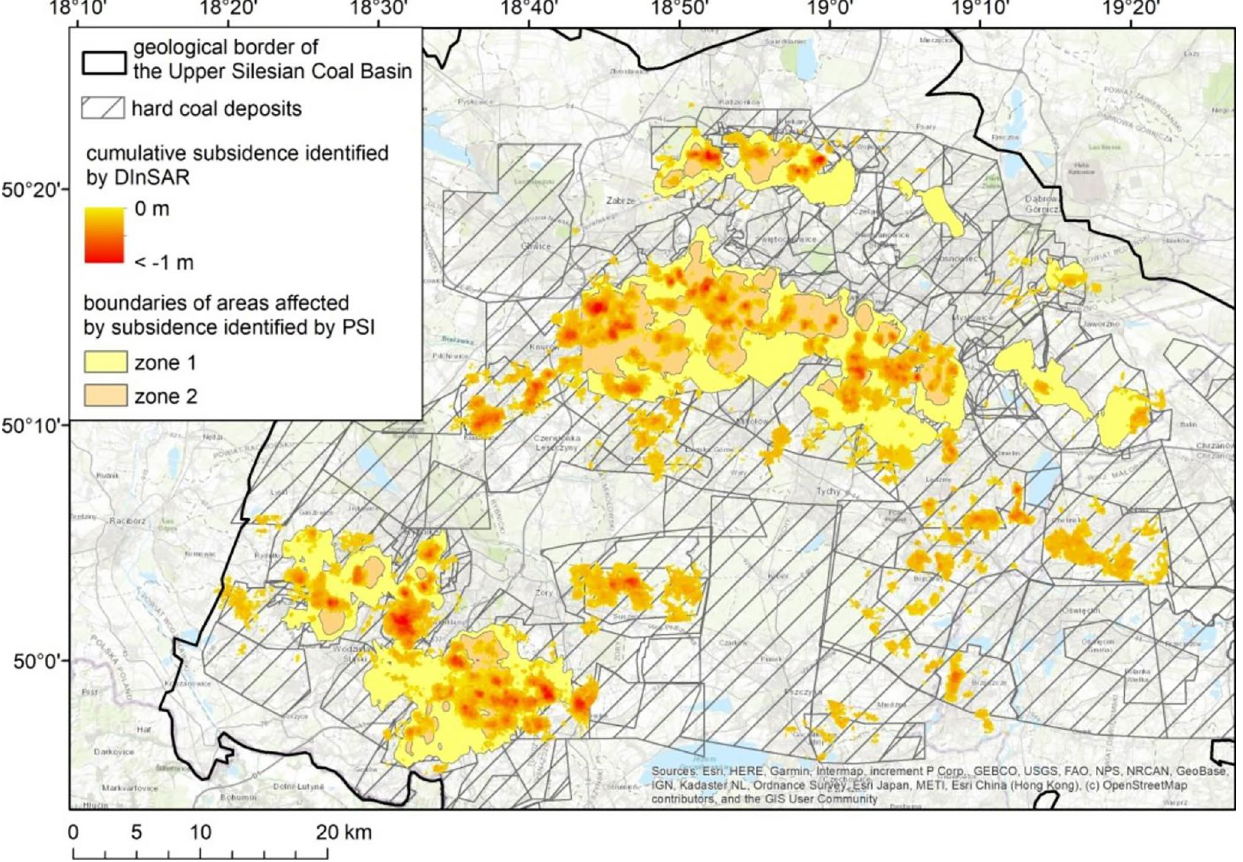
Fig. 4 The map of ground subsidence caused by mining in Upper Silesia in 1992–2012 based on InSAR data